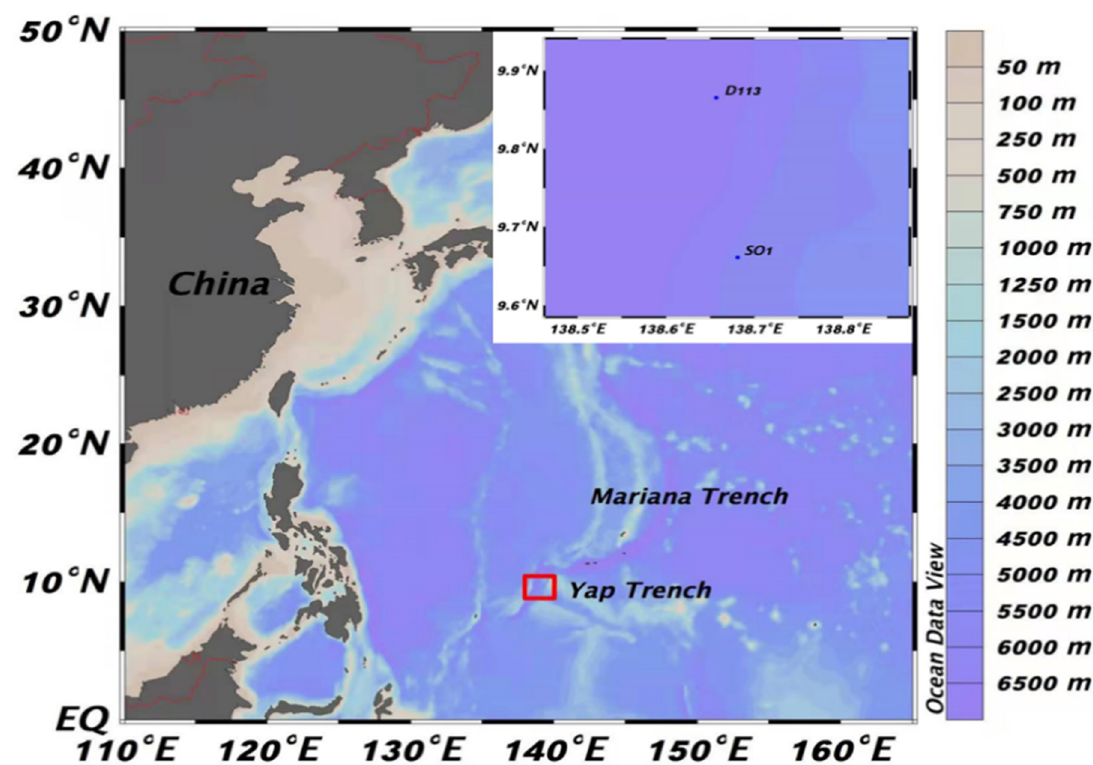
Figure 2. The location map and the sampling stations of the Yap Trench.